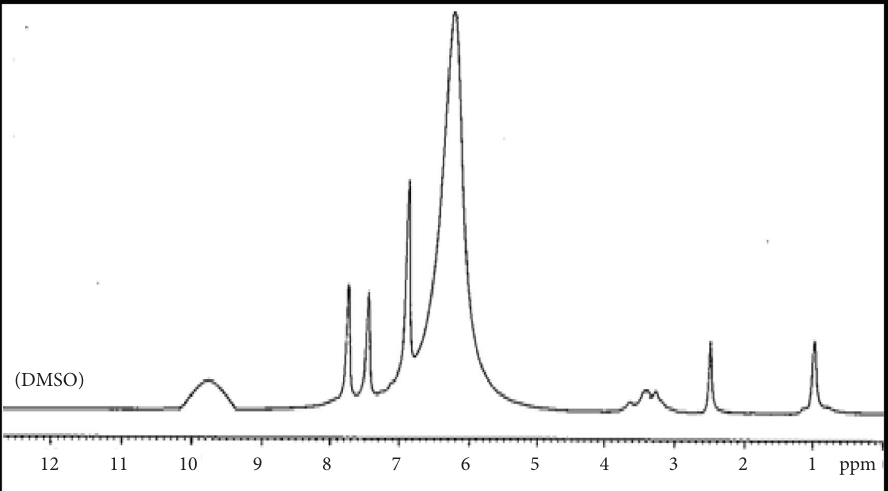
Figure 9: 1 HNMR spectra of PSA.